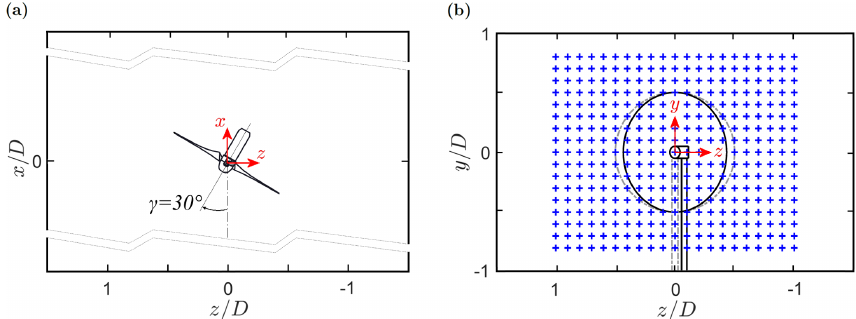
Figure 4. Reference coordinate system in the wind tunnel: (a) top view of yawed turbine setup and (b) grid for wake